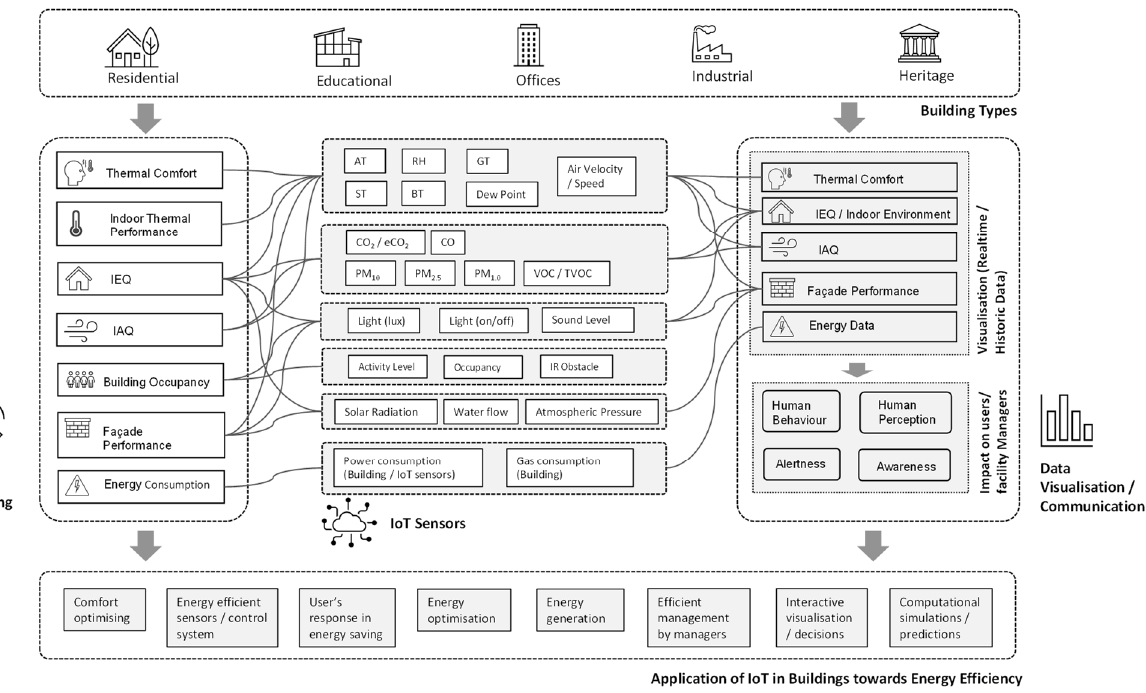
Figure 10. Application of IoT sensors in building monitoring and data visualization for energy effi- ciency.